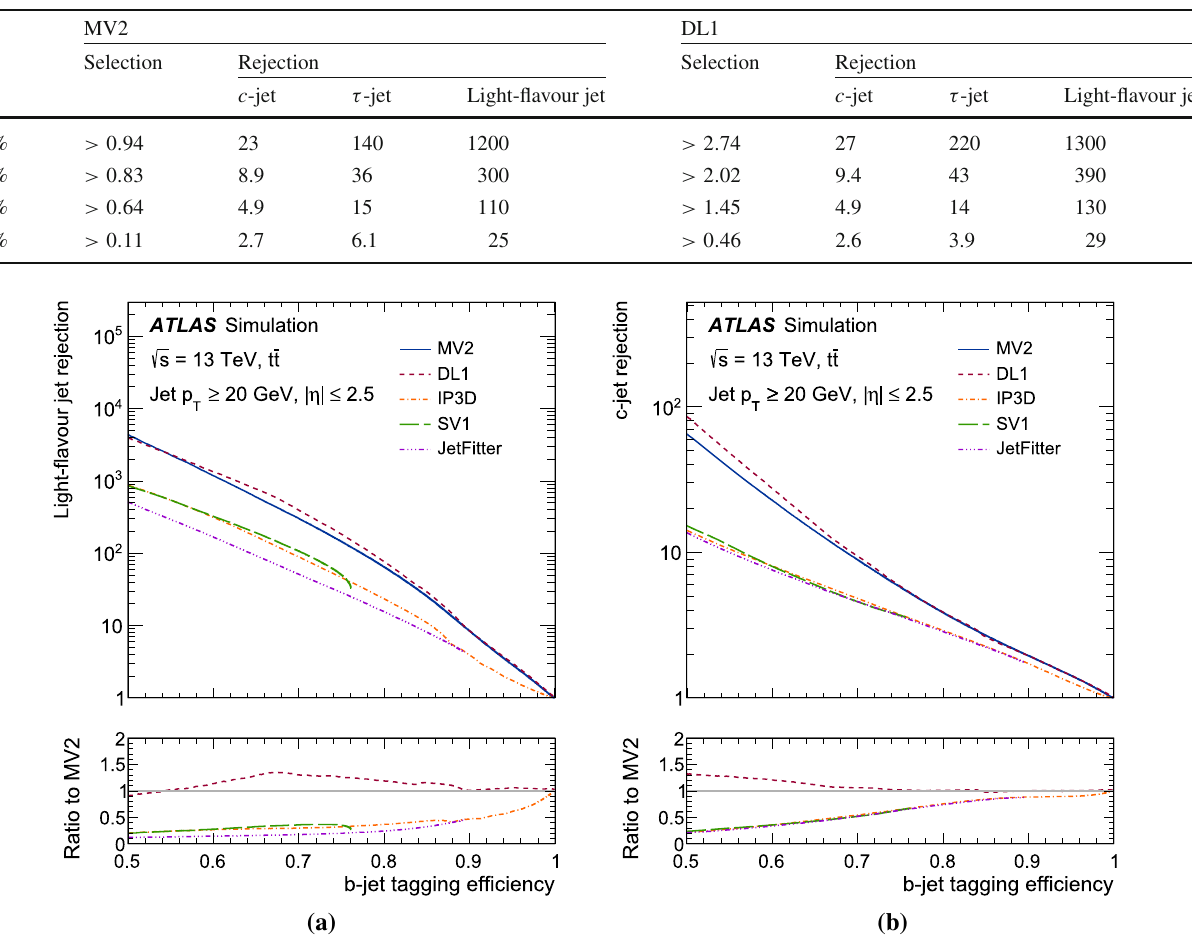
Fig. 2 The (a) light-flavour jet and (b) c -jet rejections versus the b -jet tagging efficiency for the IP3D , SV1 , JetFitter , MV2 and DL1 b